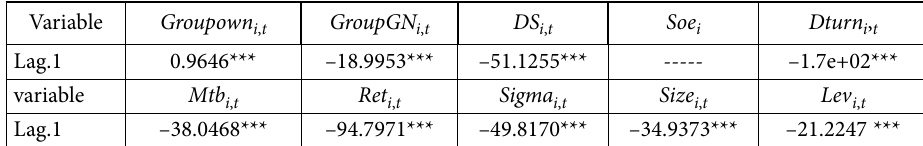
Table 4. ADF unit root test results for the variables